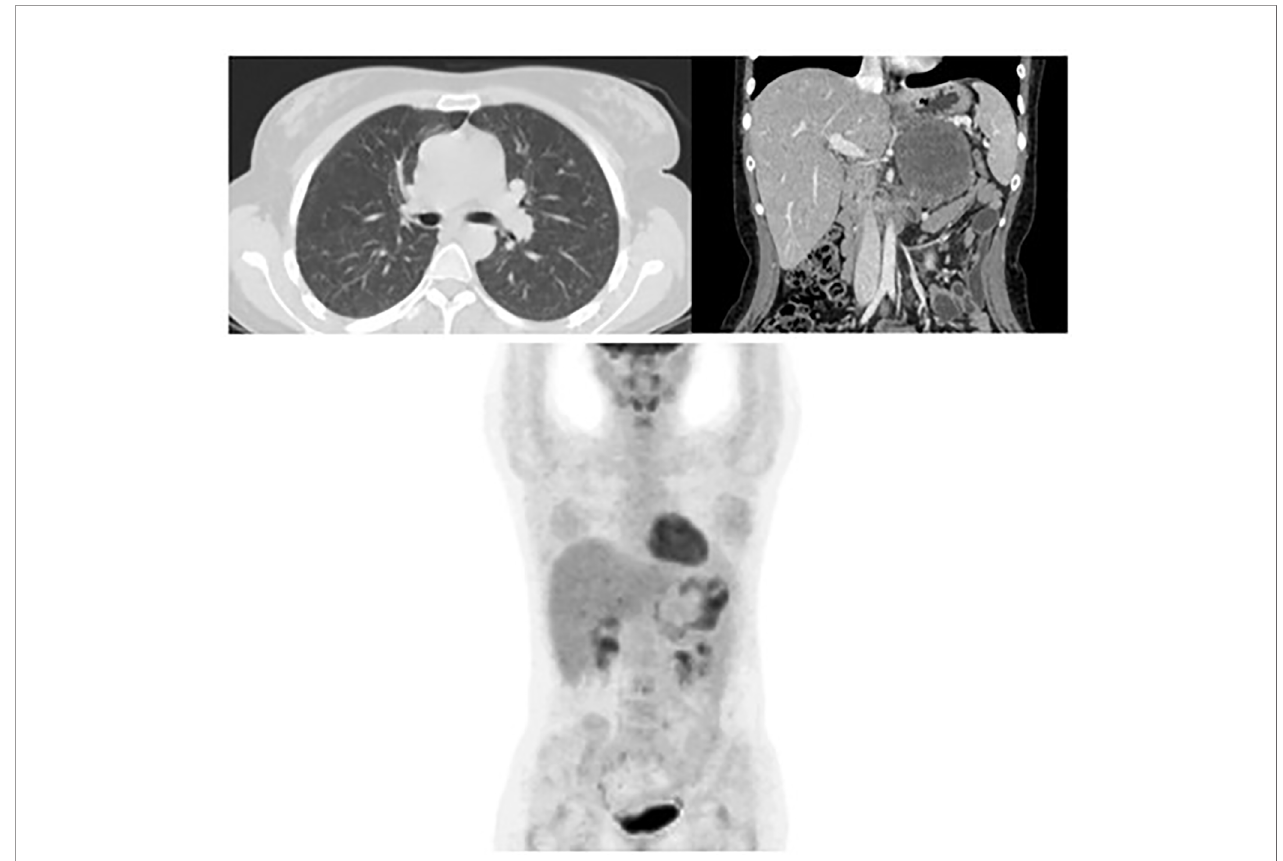
FIGURE 2 | Complete response of the bilateral lung metastases and reduction of the primary adrenal lesion at the CT Scan after 8 cycles of temozolomide. FDG PET con fi rming the complete response of lung lesions and a small peripheral area of FDG uptake at the residual adrenal mass. (September 2020).